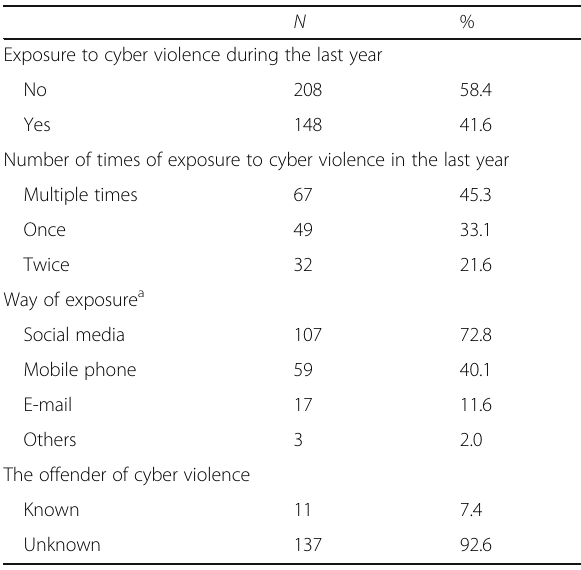
Table 3 Impact of exposure to cyber violence on